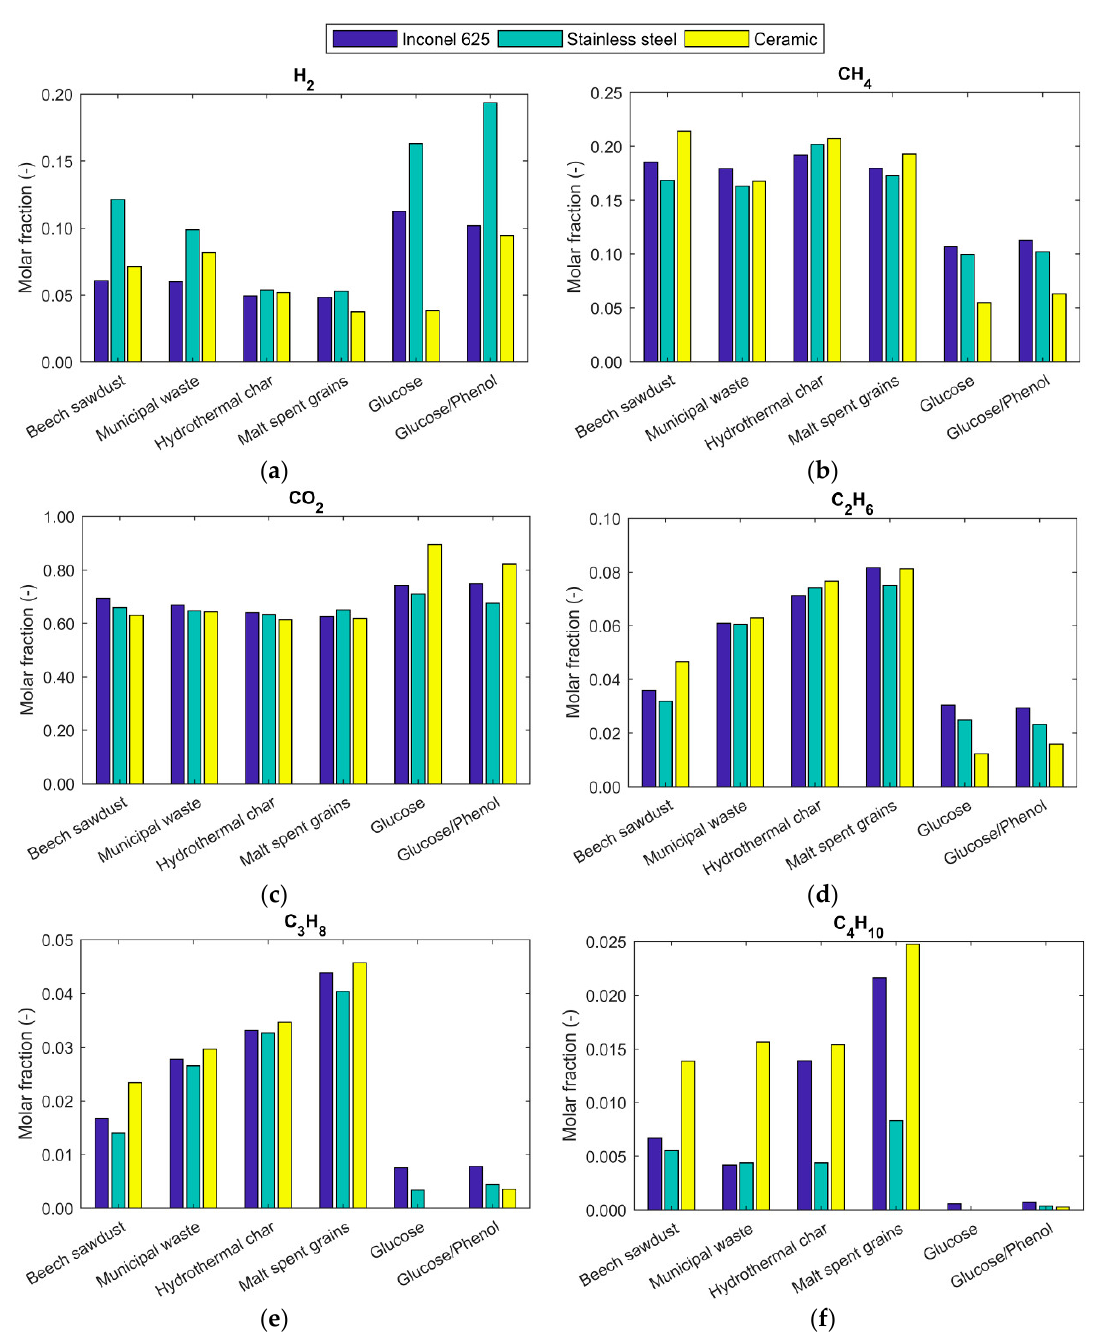
Figure 1. Gas composition (molar fractions, dry basis) of the gas produced in the SCWG